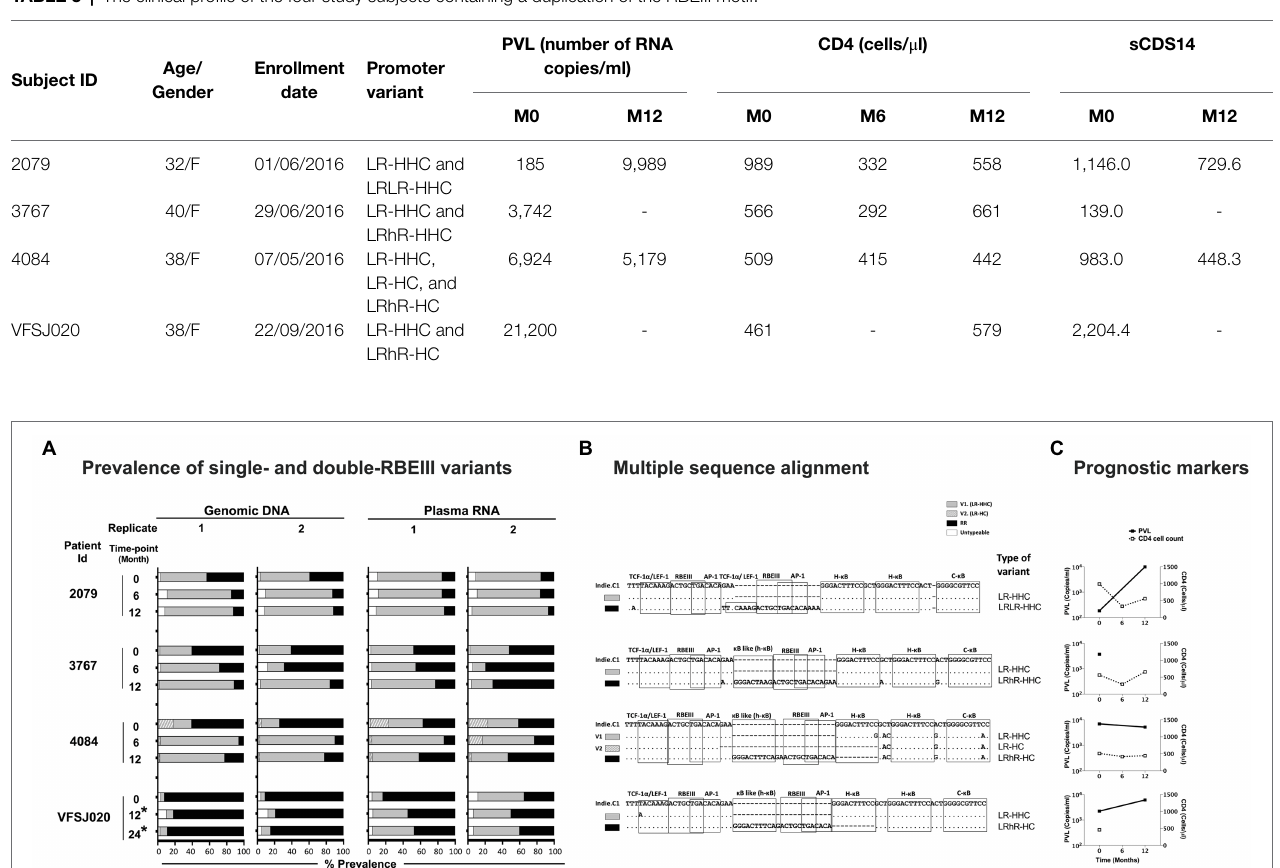
TABLE 3 | The clinical profile of the four study subjects containing a duplication of the RBEIII motif.